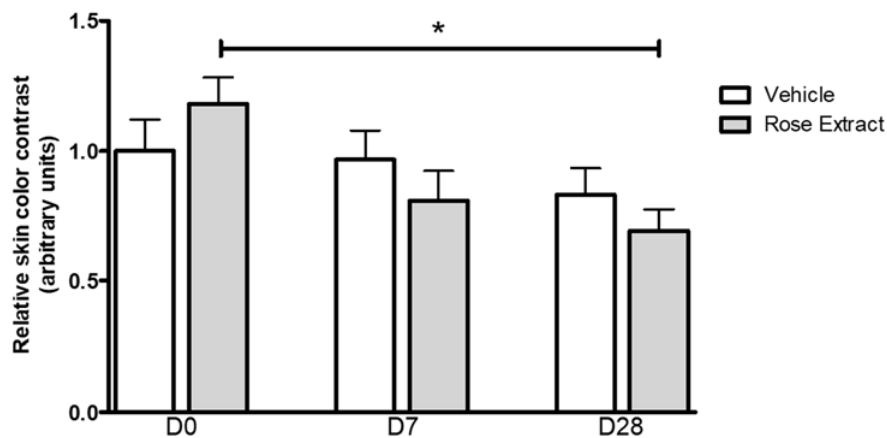
Figure 4. Efficacy of rose extract (5 × 10 − 3 %) treatment for under eye dark circles. Skin color contrast evolution between normal skin and dark circles. Data are presented as mean ± SEM values, ( n = 8). Statistical analysis was performed using ANOVA (* p ≤ 0.05).